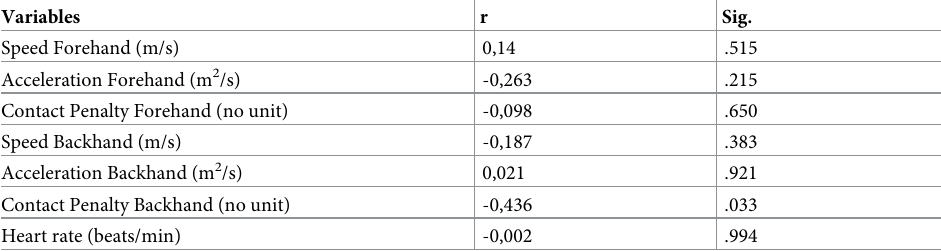
Table 3. Correlations between difference and mean of two